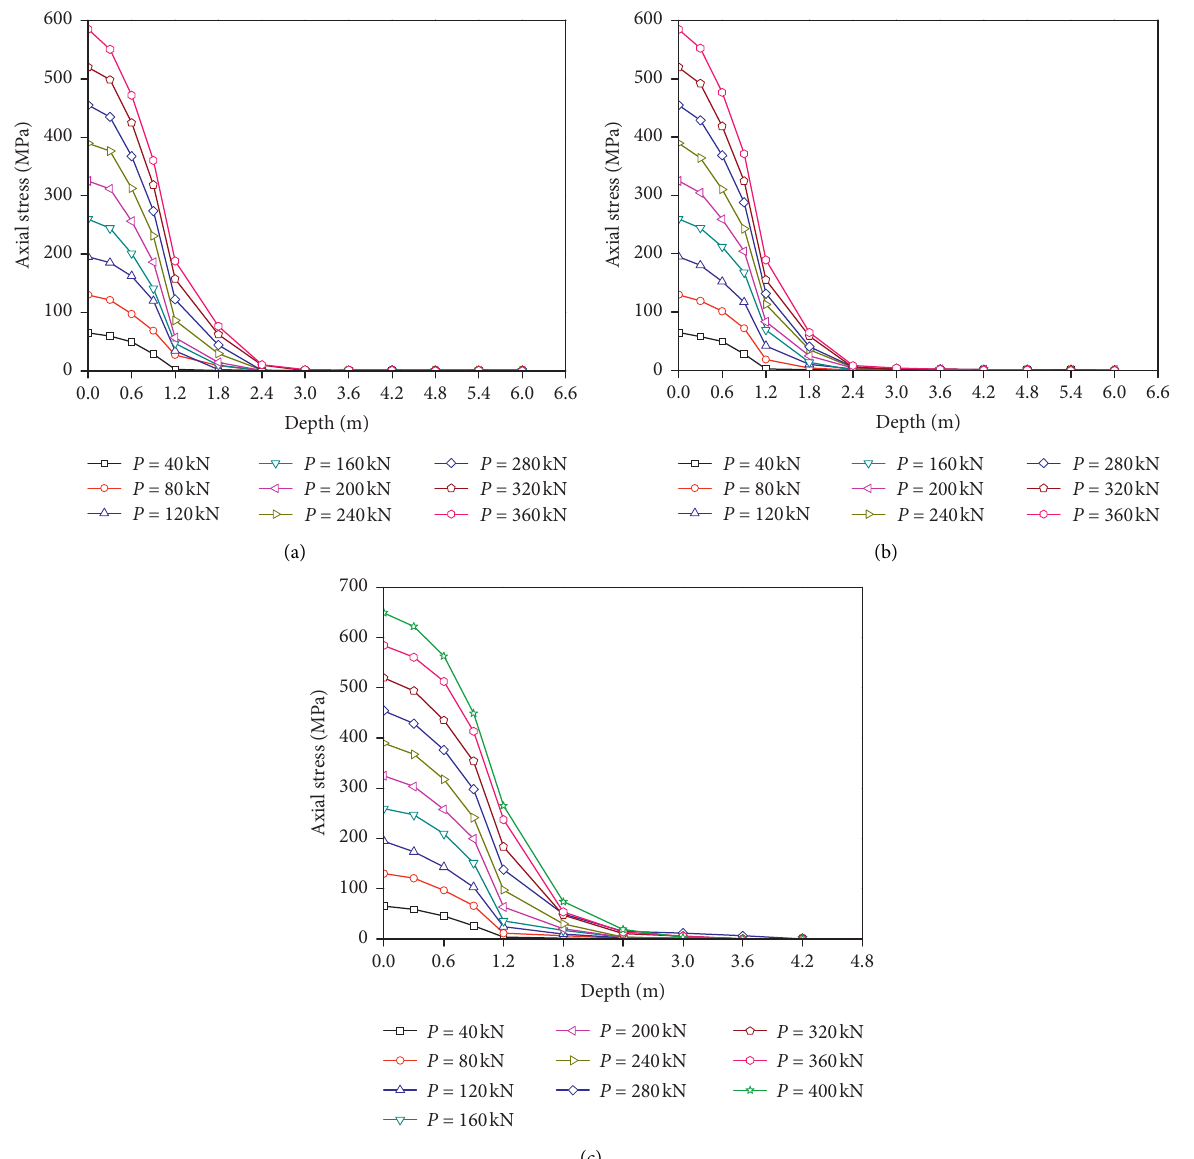
Figure 11: Axial stress of rod cross-section at different depths: (a) G-28-6.5-1, (b) G-28-6.5-2, and (c)